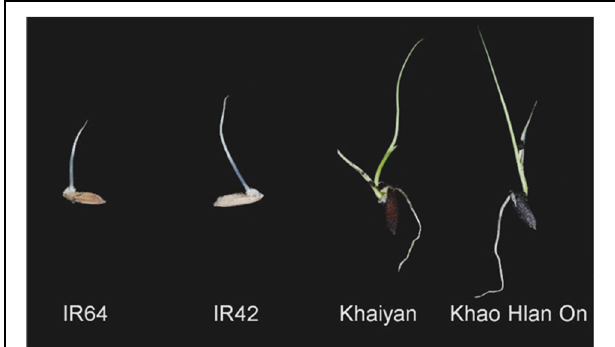
FIGURE 1 | Left to right: seedlings of sensitive varieties “IR64” and “IR42” and tolerant landraces “Khao Hlan On” and “Khaiyan” 7 days after sowing in soil and flooding with 10cm of water (from image collection of the International Rice Research Institute (IRRI) publicly available at Flickr http://www.flickr.com/photos/ricephotos/21995